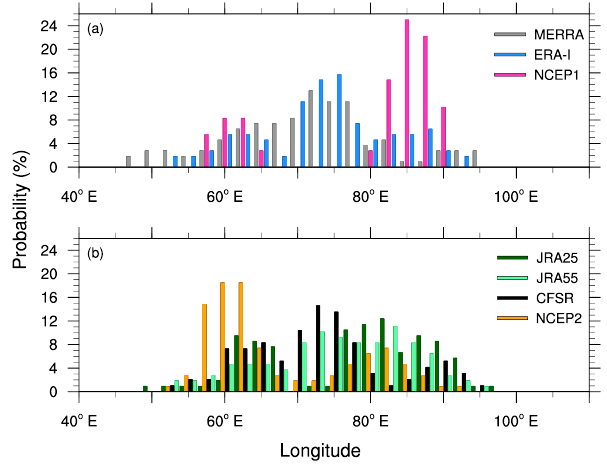
Figure 7. As Fig. 6 but for seasonal mean (JJA)